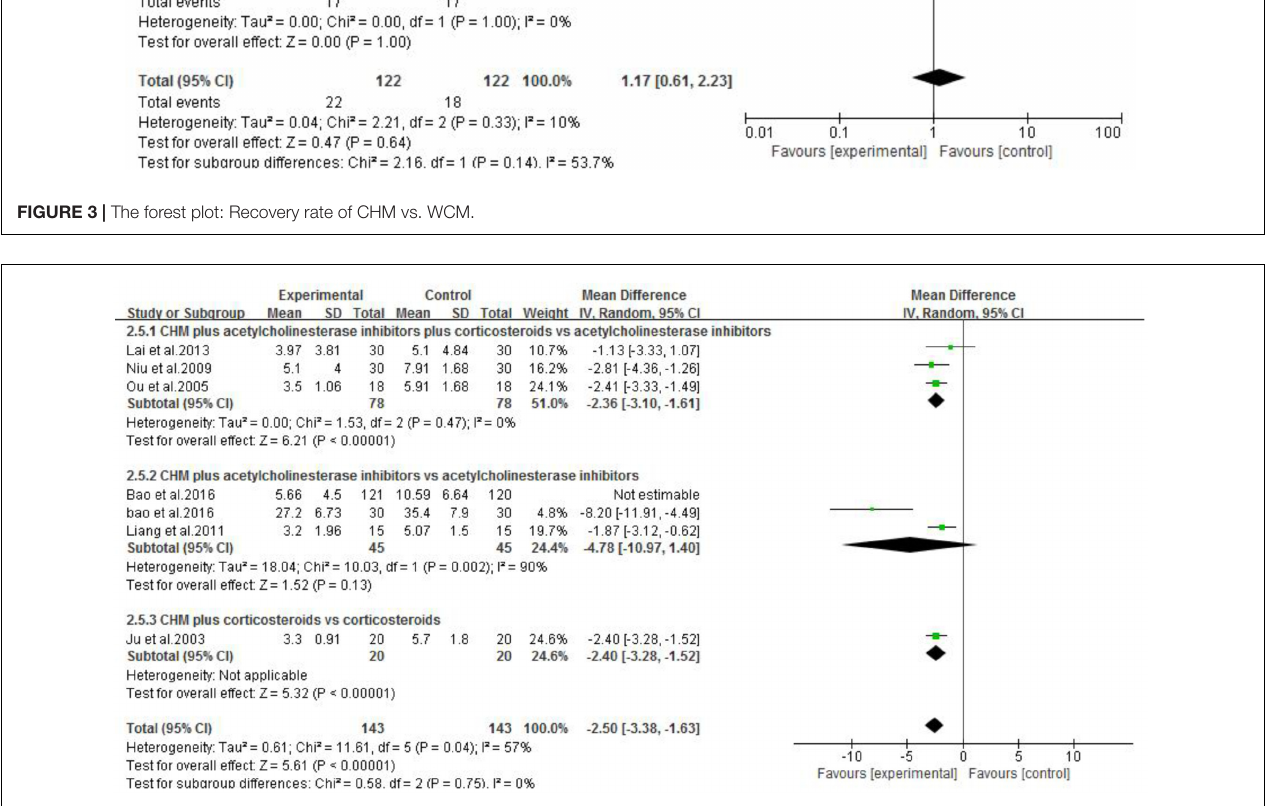
FIGURE 4 | The forest plot: MG clinical absolute and relative scores of CHM plus WCM vs.